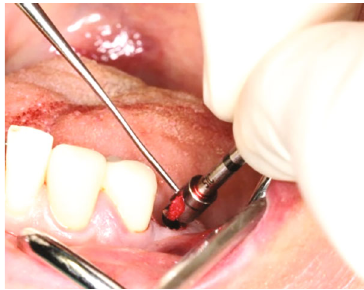
Figure 11: Subcrestal relocation of local bone (bone chips from the crestal cutter, SIC Crestal Cutter) on the implant shoulder following insertion of the implant cover screw.